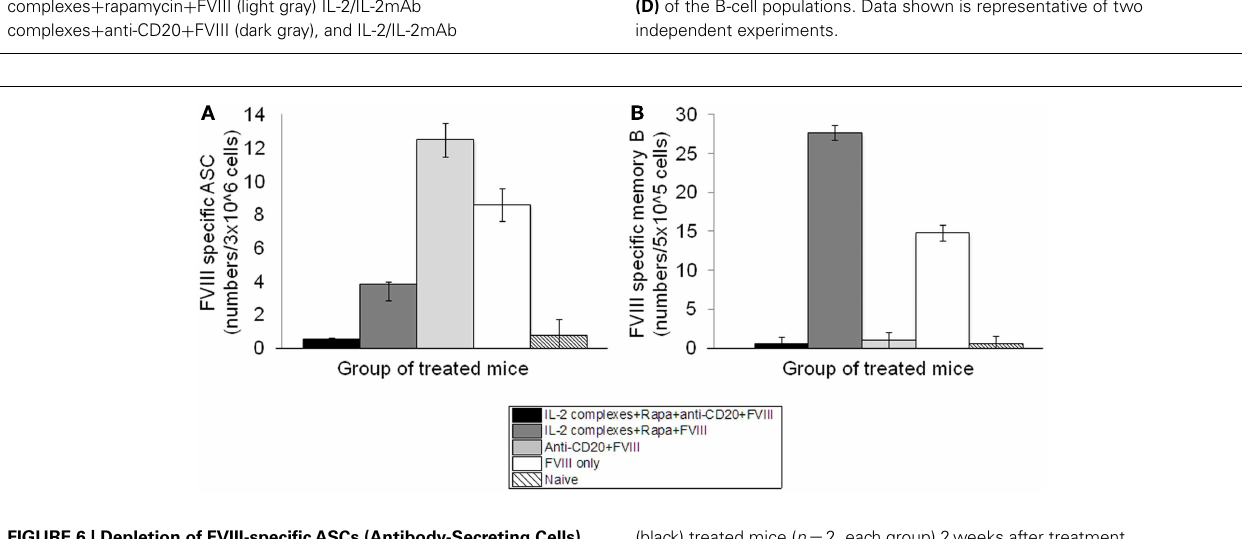
FIGURE 6 | Depletion of FVIII-specificASCs (Antibody-Secreting Cells) and memory B-cells in the inhibitor mice treated with IL-2/IL-2mAb complexes plus rapamycin and anti-CD20 . Cells were isolated by MACS from spleens of naive (light slant), FVIII plasmid only (white), anti-CD20 + FVIII (light gray), IL-2/IL-2mAb complexes + rapamycin + FVIII (dark gray), and IL-2/IL-2mAb complexes + rapamycin + anti-CD20 + FVIII